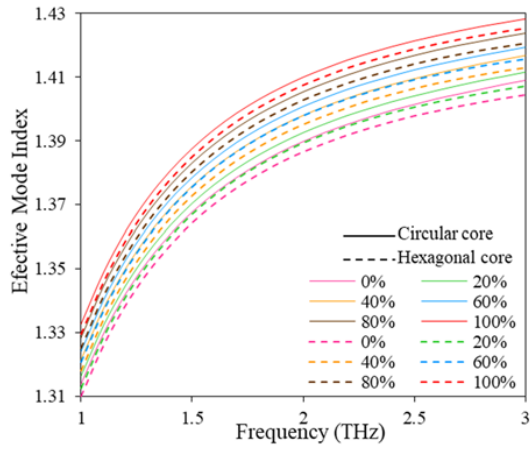
Figure 4. Effective mode index for hexagonal and circular core with the change of